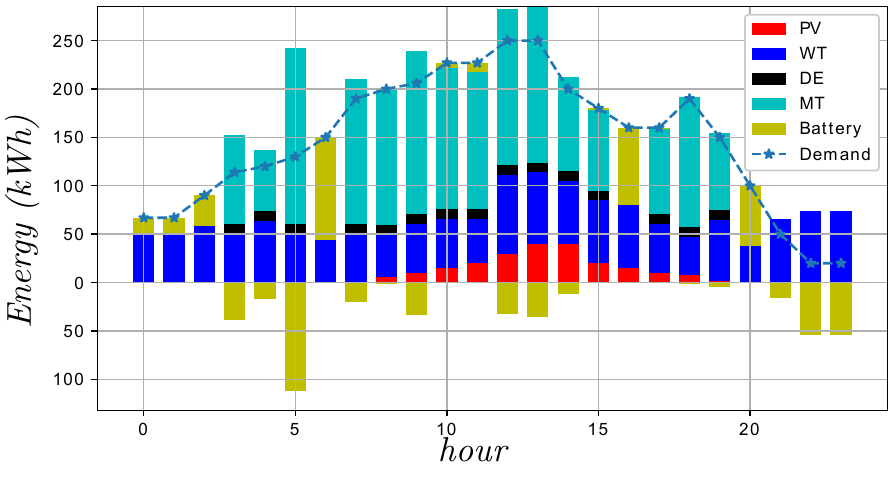
Figure 10. UC and ED solution for Case Study 2.